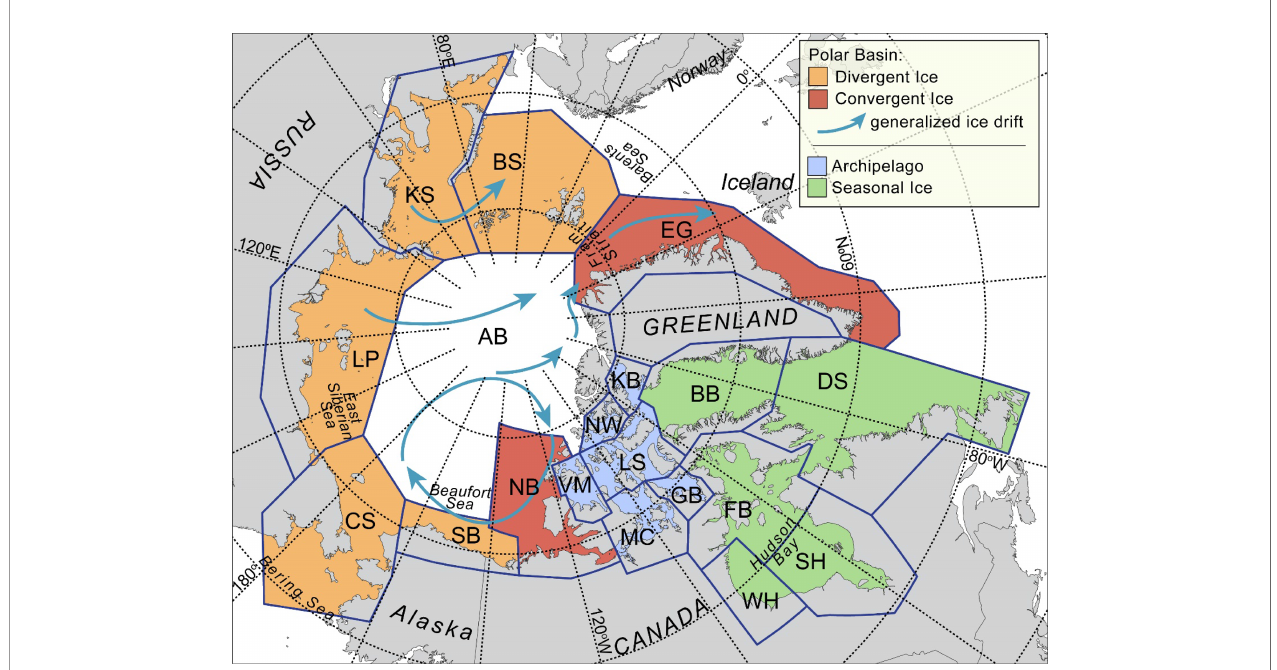
FIGURE 2 | Polar bear ecoregions, 19 subpopulations (AB, Arctic Basin; BB, Baf fi n Bay; BS, Barents Sea; CS, Chukchi Sea; DS, Davis Strait; EG, East Greenland; FB, Foxe Basin; GB, Gulf of Boothia; KB, Kane Basin; KS, Kara Sea; LP, Laptev Sea; LS, Lancaster Sound; MC, M ’ Clintock Channel; NB, Northern Beaufort Sea; NW, Norwegian Bay; SB, Southern Beaufort Sea; SH, Southern Hudson Bay; VM, Viscount Melville Sound; WH, Western Hudson Bay), and place names mentioned in the text with arrows showing ice drift. Ecoregions as de fi ned by Amstrup et al.